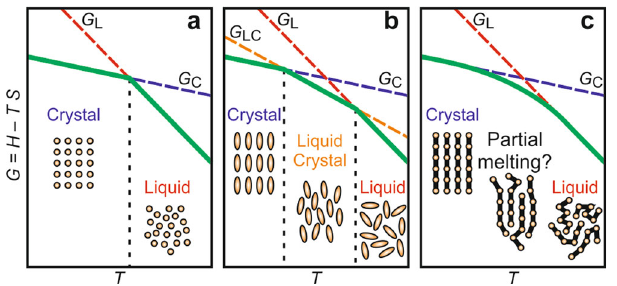
Fig. 1 Schematic free energy-temperature pro fi les for crystal-liquid phase transition. a A normal crystal. b A liquid-crystalline compound. c Hypothetic scenario for long-chain molecules/polymers. C, LC, and L are crystal, liquid crystal, and liquid phases.